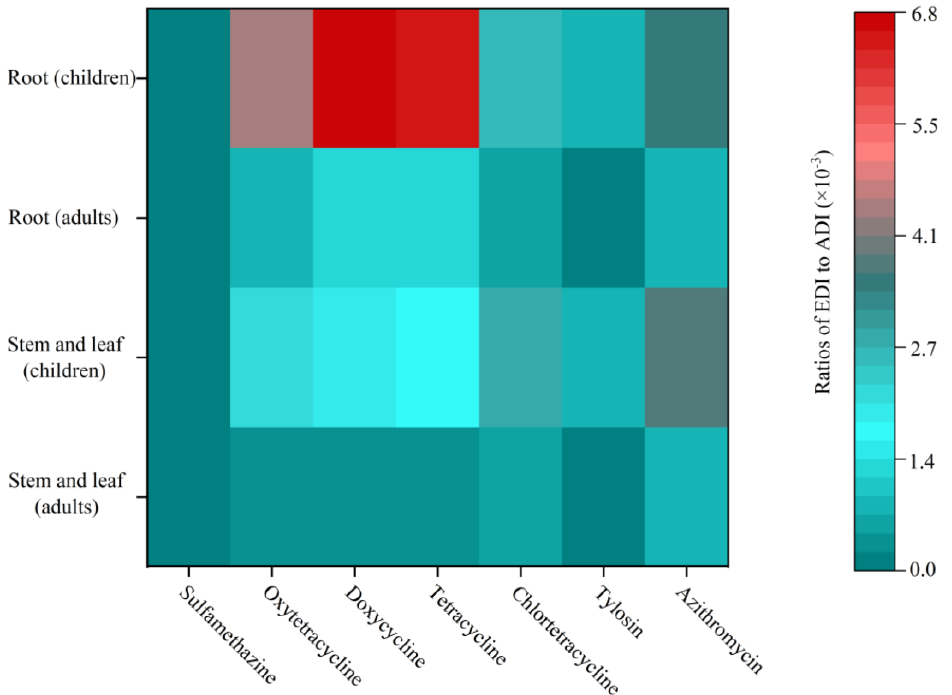
Figure 2. The ratios of estimated daily intake (EDI) to acceptable daily intake (ADI) for each antibiotic. A hazard quotient of ≥0.1 indicates it poses a threat to human health.